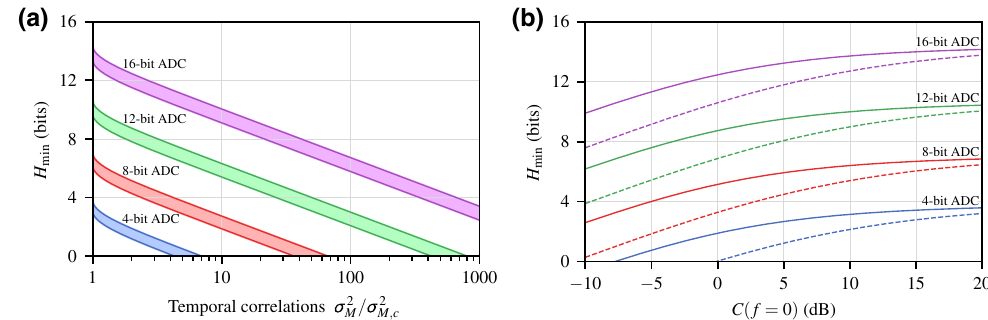
/σ 2 . Here, σ 2 and M M , c M , c